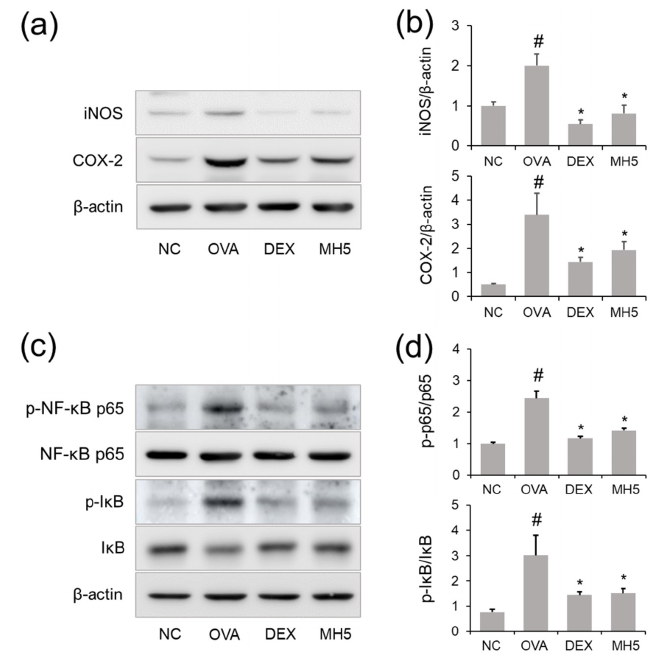
Figure 9. Effects of MH on iNOS/COX − 2 expression and NF − κ B activation in mice with AA. ( a , b ) The levels of iNOS and COX − 2 in lung tissues were detected using Western blotting, and quantitative analysis was performed using ImageJ software. ( c , d ) The levels of p − NF −κ B p65 and p − I κ B α in lung tissues were detected using Western blotting, and quantitative analysis was performed using ImageJ software. Data are expressed as the mean ± SD (n = 3) ( # p < 0.05 for comparison with normal control; * p < 0.05 for comparison with OVA group).